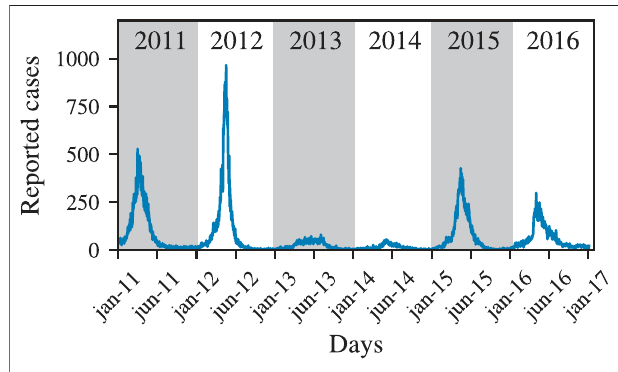
TABLE 1 | Number of dengue cases reported in Fortaleza between 2011 and 2016. The processed subcolumn contains the original number of